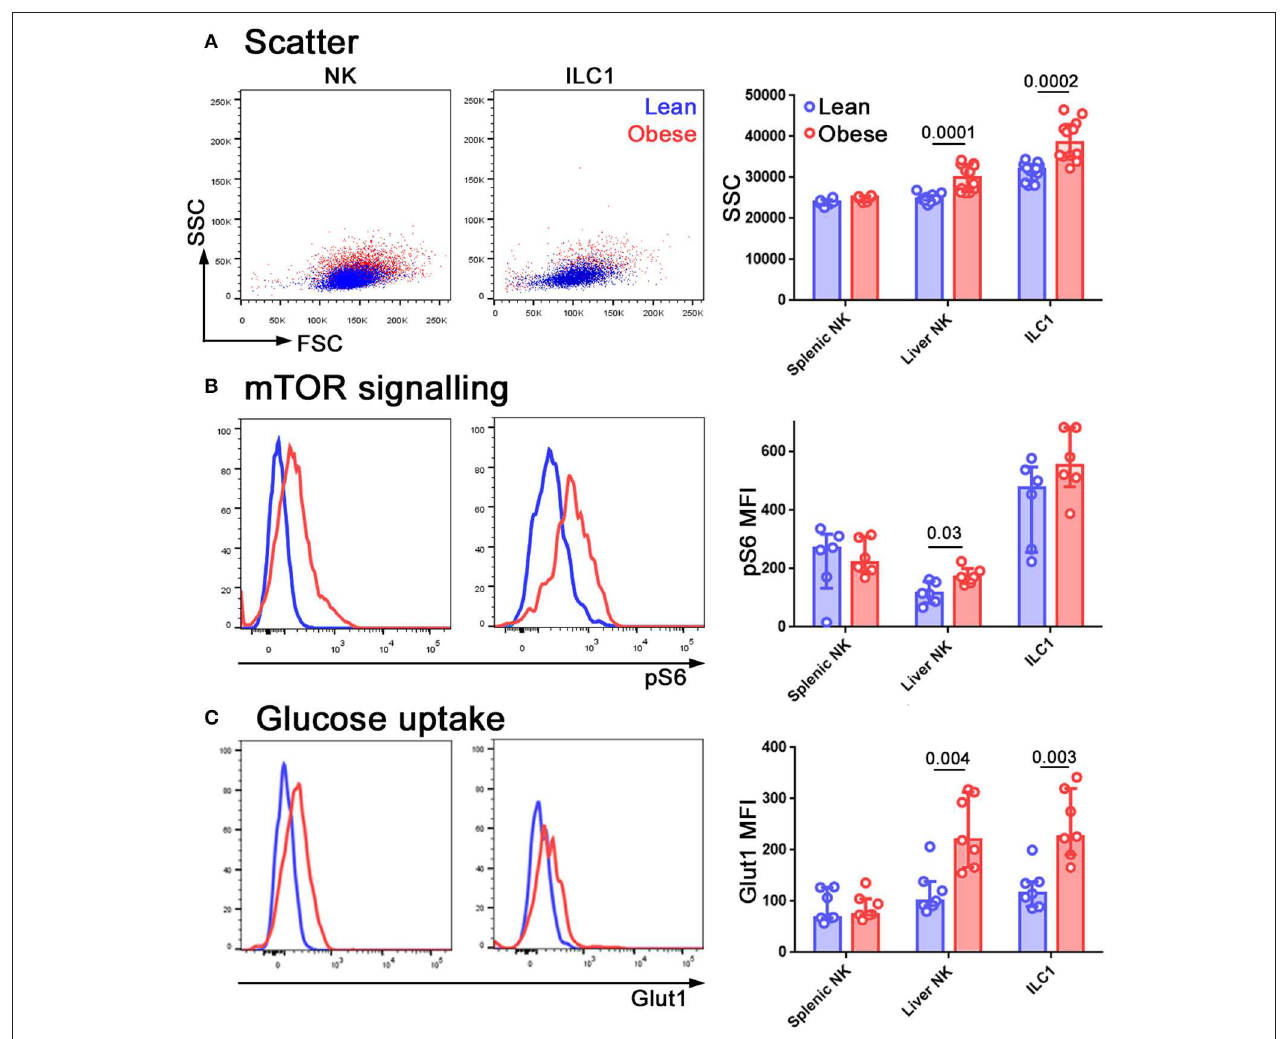
FIGURE 4 | NK cells in the livers of obese mice are metabolically reprogrammed. Forward and side scatter (A) , pS6 staining (B), and Glut1 staining (C) of freshly isolated NK cells and ILC1 from lean (blue) and obese (red) mice. n = 12 mice per group (A) , six mice per group (B) and seven mice per group (C) ; significance was determined using Mann Whitney U -Tests; medians and IQRs are